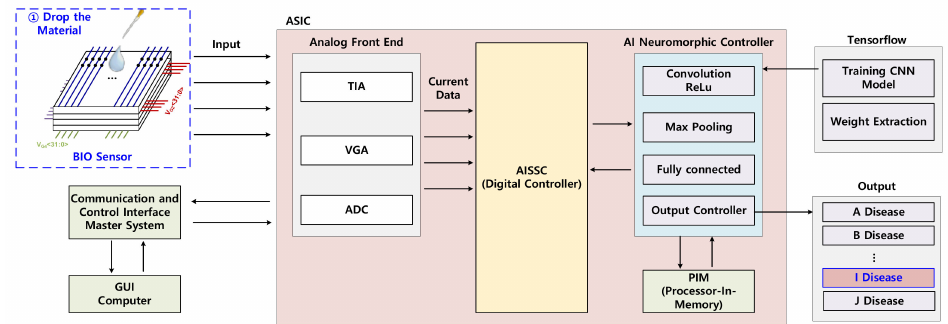
Figure 1. Top Architecture of Analog-Digital Hybrid Convolutional Neural Network in a